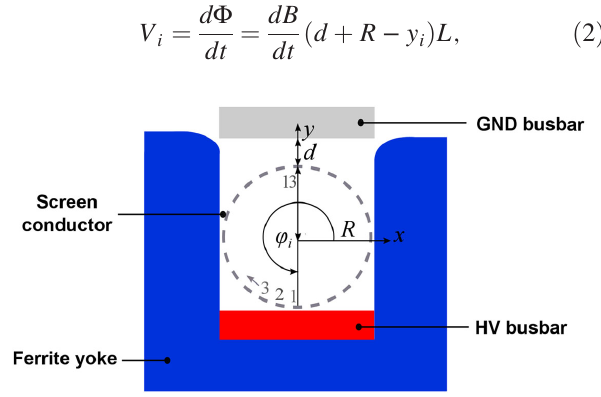
FIG. 4. Schematic cross section of a beam screen inside the aperture of the kicker magnet. The dashed circle represents the position of each screen conductor, either straight or helical, inside the alumina tube.